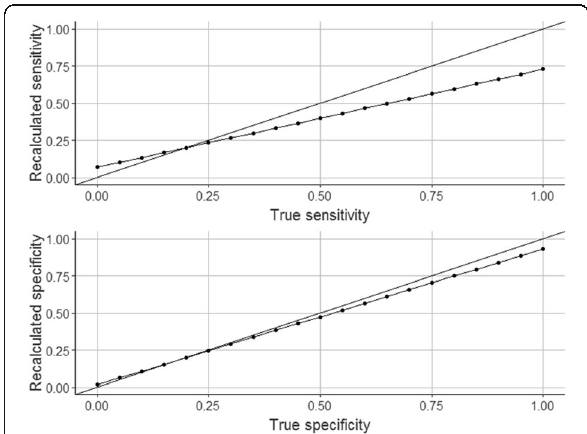
Fig. 1 (abstract O14). Bias in estimates of index test sensitivity and specificity for a range of true values as result of dichotomization of the reference